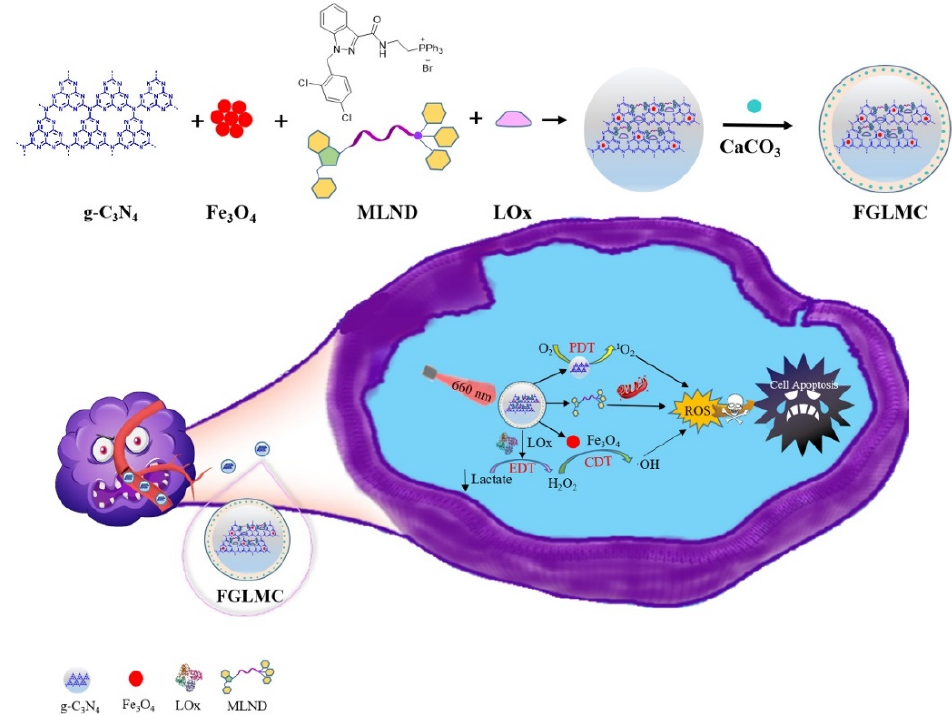
Scheme 1. Scheme illustration of the composition of FGLMC and its therapeutic effect on breast cancer.